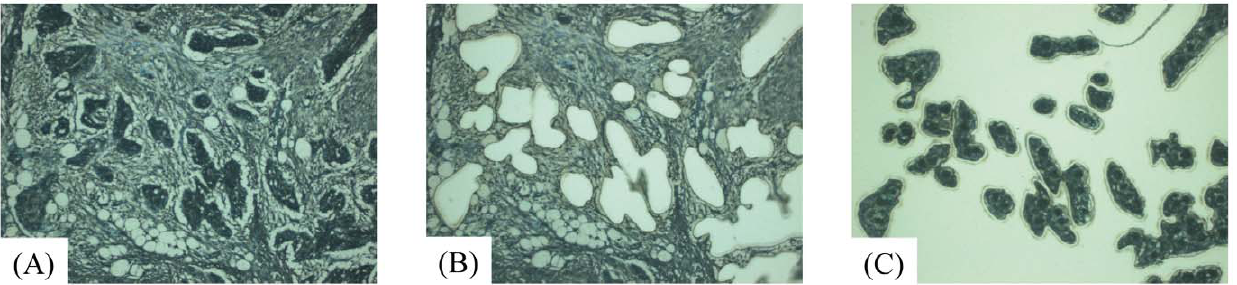
Figure 1. Representative processes of laser-capture microdissection. Tissue sections were stained with toluidine blue for laser-capture microdissection. Tissue sections before and after microdissection are shown in (A) and (B), respectively. Tumor cells harvested on the film are shown in (C).